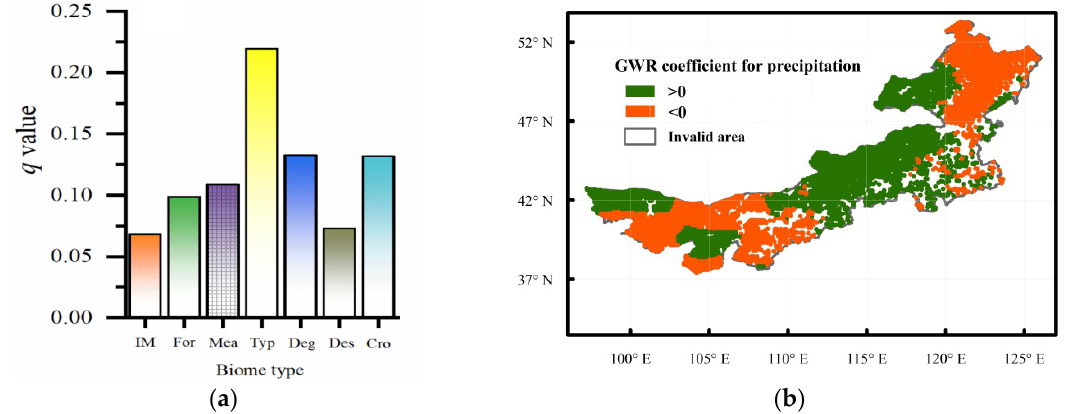
Figure 8. The power of precipitation variation for determining the CVs of the growing season NDVI from the geographical detector ( a ) and regression coefficient between CVs of the growing season NDVI and those of precipitation from GWR ( b ) during 1982–2015.